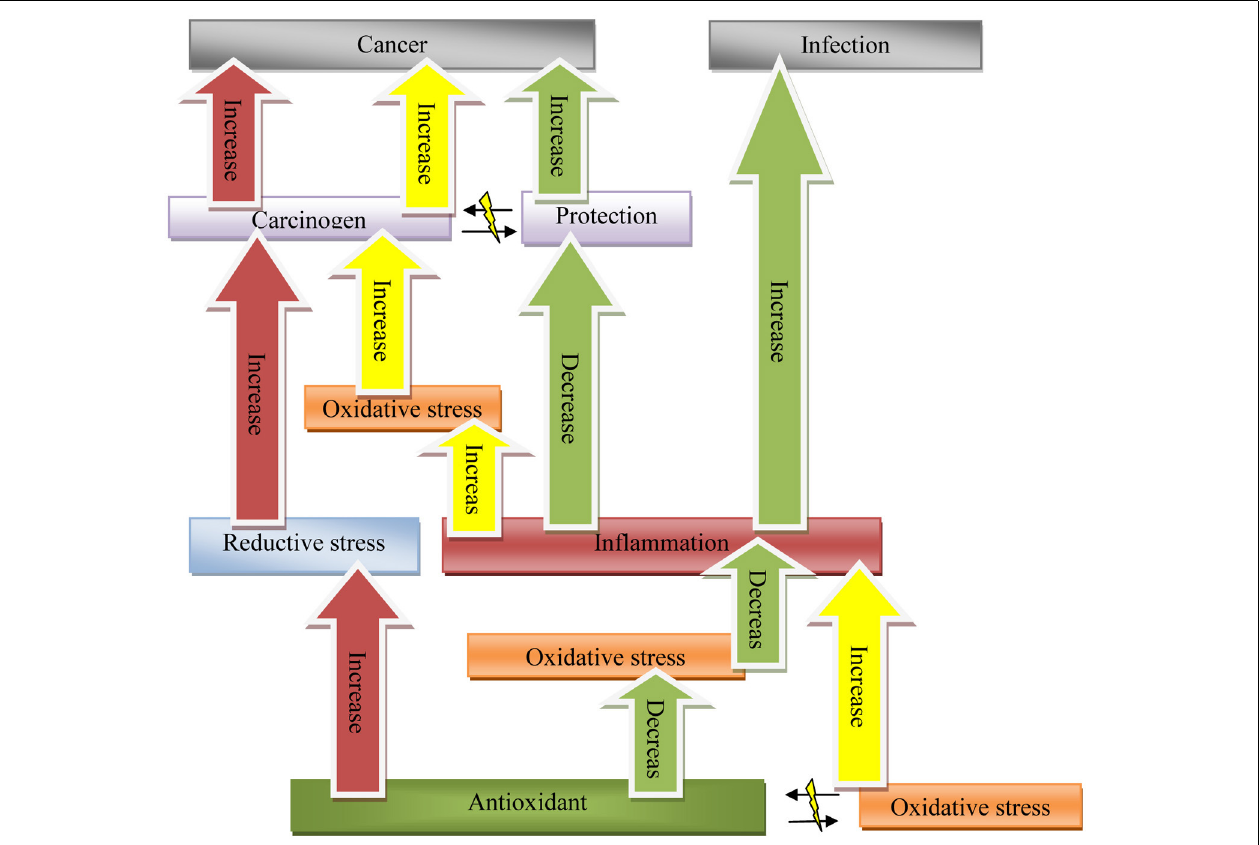
FIGURE 1 | A comprehensive model for oxidative stress, antioxidants, inflammation, and carcinogenesis: oxidant-antioxidant equilibrium, cancer protection, and carcinogenesis equilibrium are described as